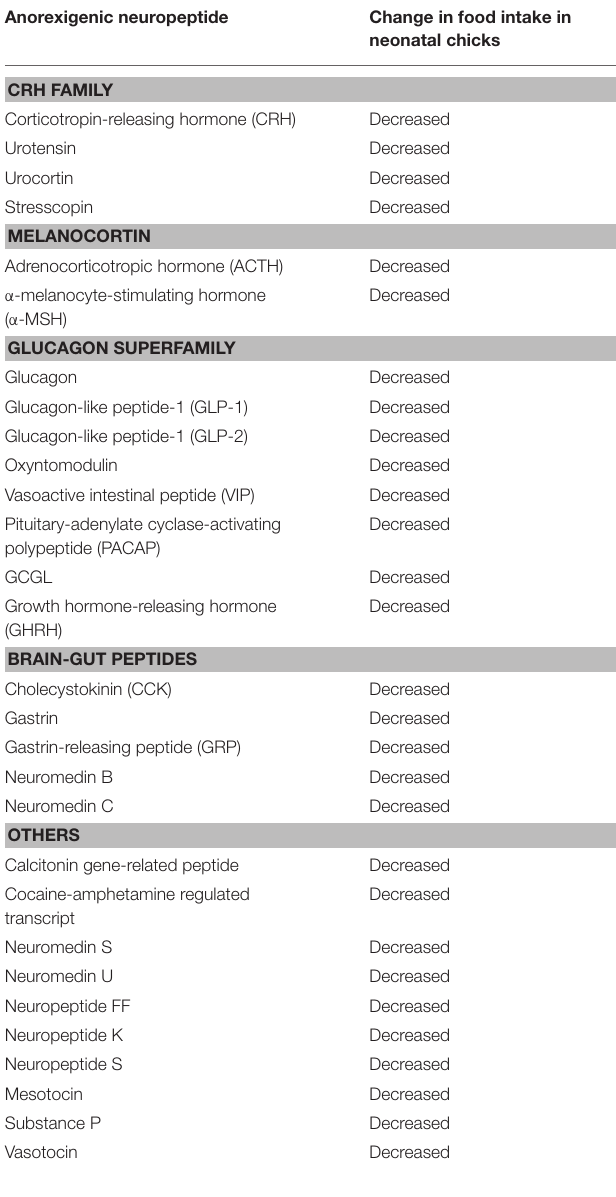
TABLE 1 | Neuropeptides showing anorexigenic effects on feeding behavior in birds. Anorexigenic